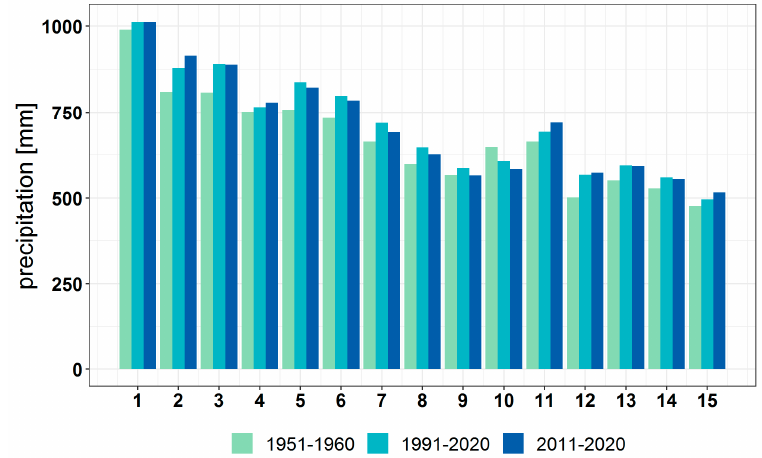
Figure 10. The variation of average annual precipitation over the analyzed period for the main forest types.